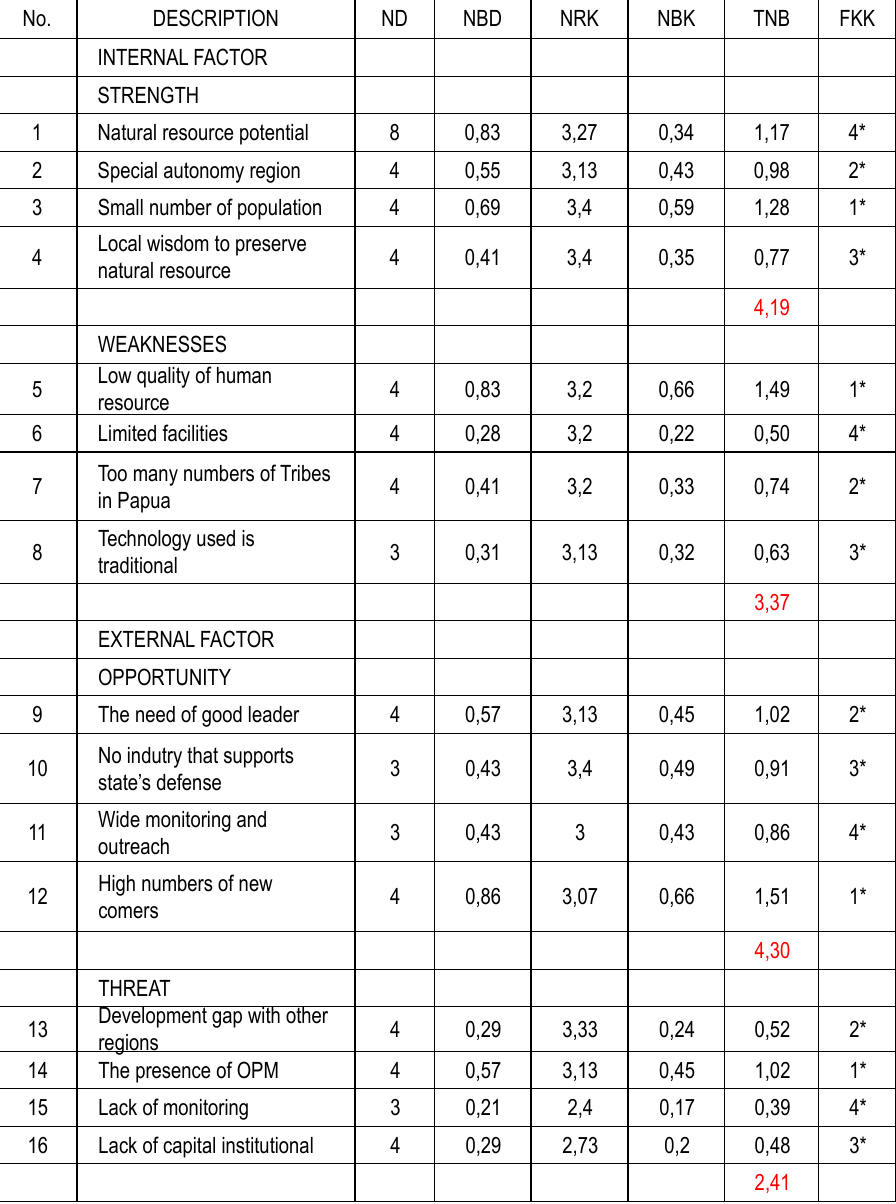
Table 1. Internal and External Factors SWOT Papua case